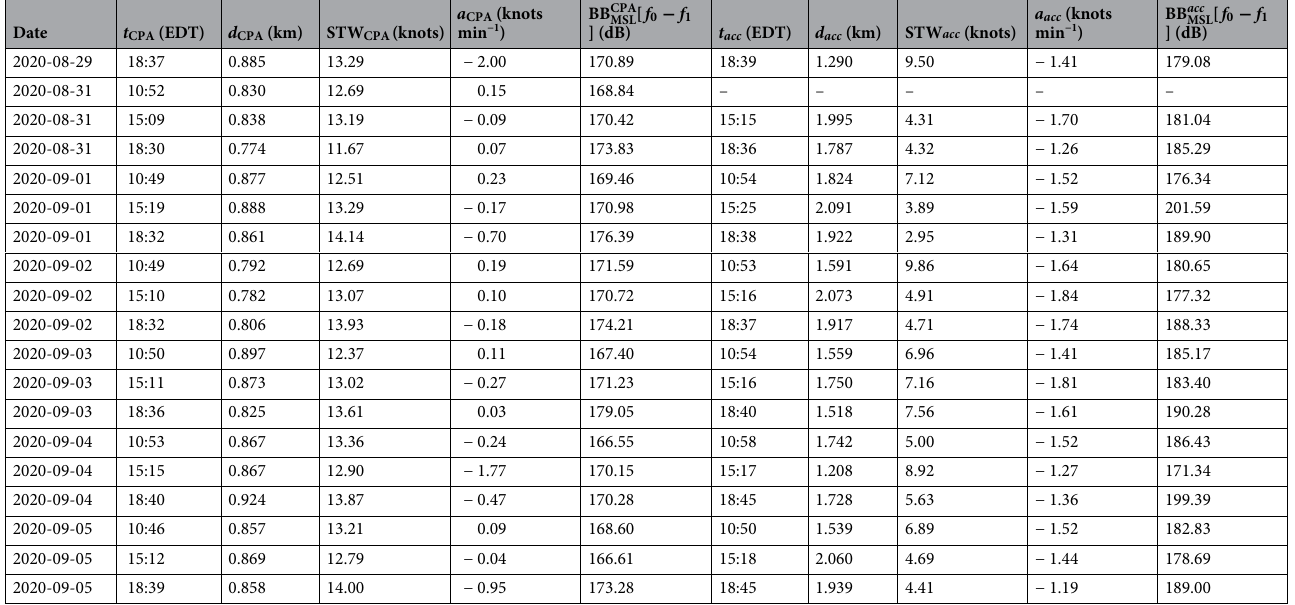
Table 5. Data collected of the N.M. Trans-Saint-Laurent’s Transits during the 2020 SLE Summer